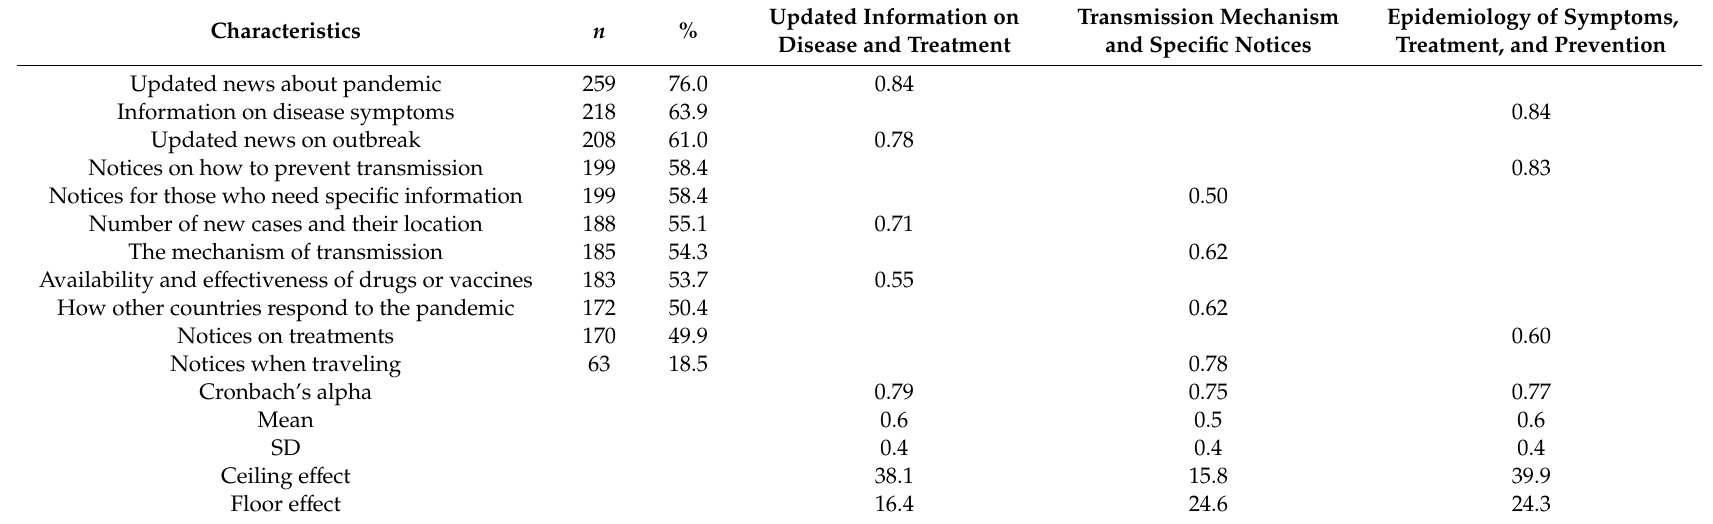
Table 2. Demand for health information about